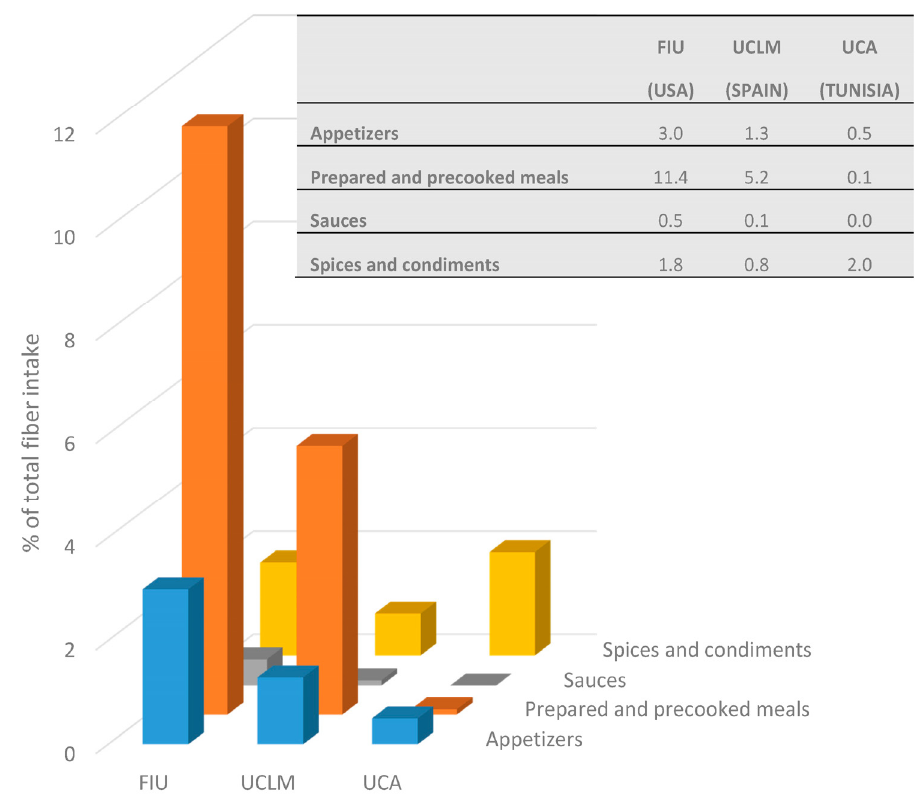
Figure 3. Fiber from appetizers, prepared and precooked meals, sauces, and spices and condiments (% of total fiber intake).